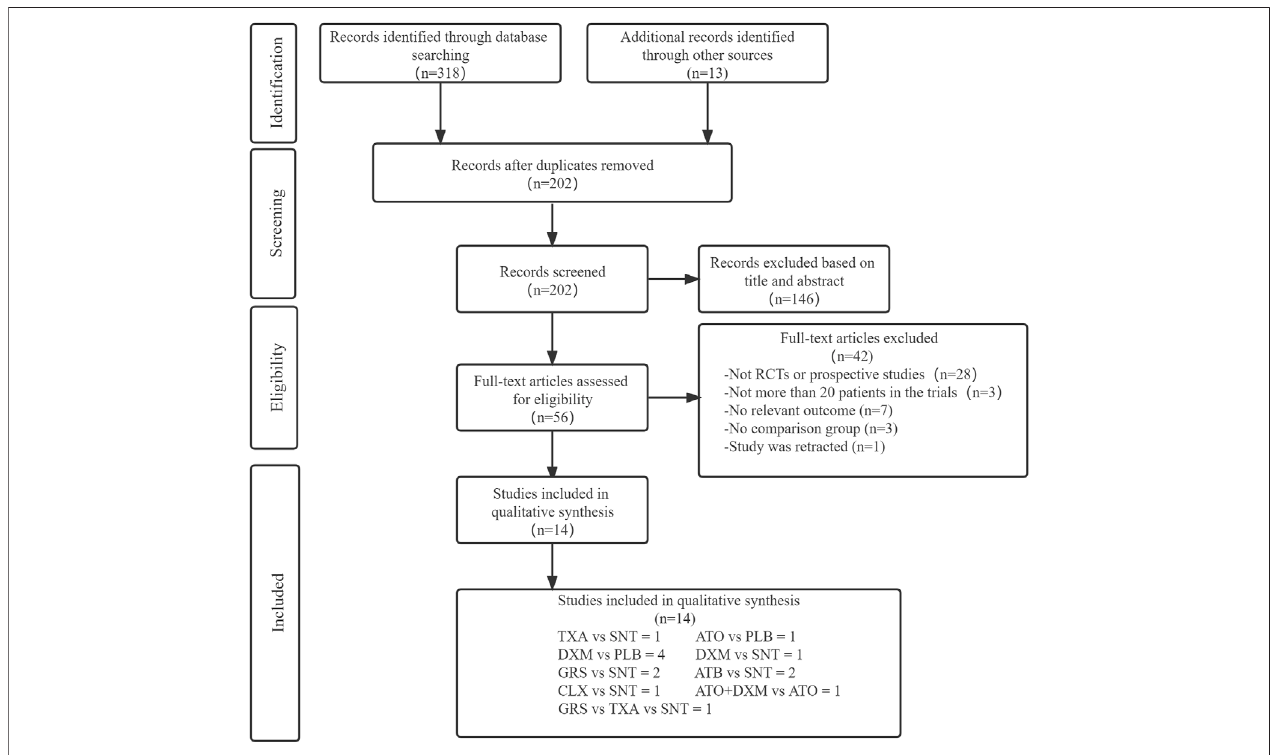
FIGURE 1 | Screening chart graph. Abbreviations: TXA, tranexamic acid; DXM, dexamethasone; ATO, atorvastatin; GRS, goreisan; CLX, celecoxib; ATO+DXM, atorvastatin plus dexamethasone; ATB, antithrombotic; PLB or SNT, placebo or standard neurosurgical treatment; RCT, randomized controlled study.